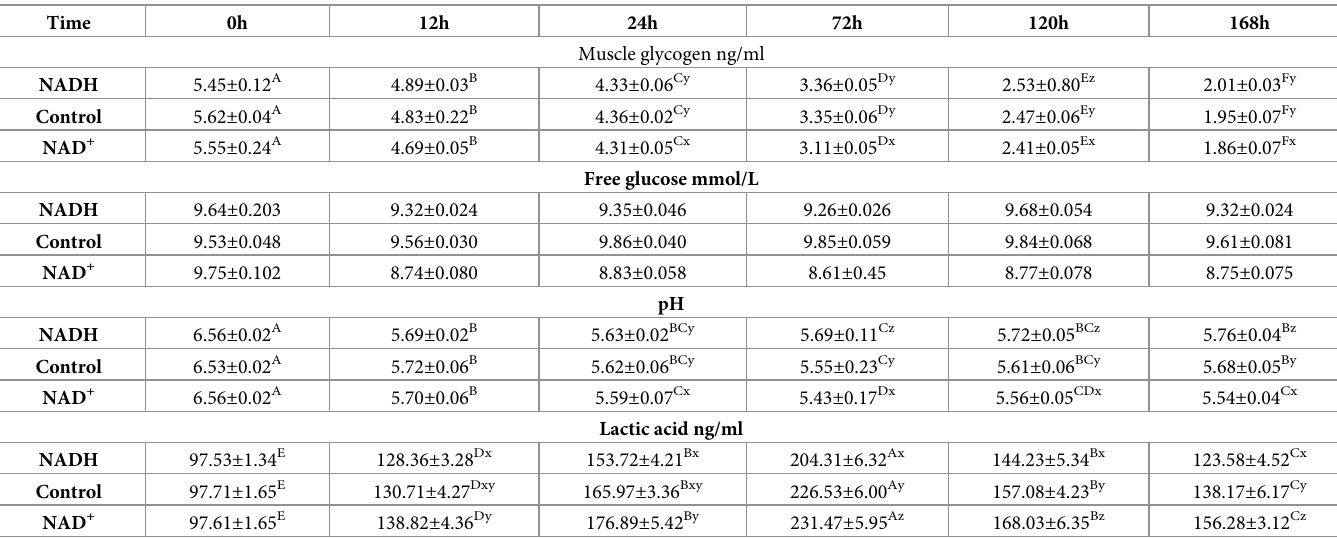
Table 1. Changes of glycolysis index in the process of maturation of slaughtered yak.